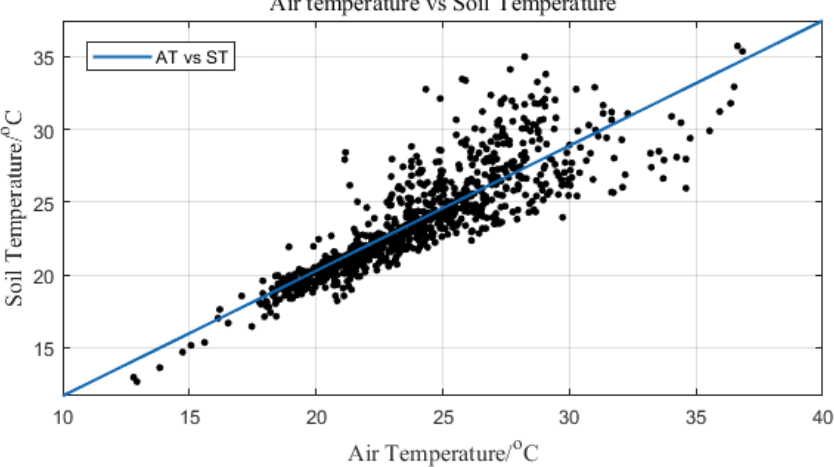
Figure 13. Correlation between the air temperature and soil temperature.